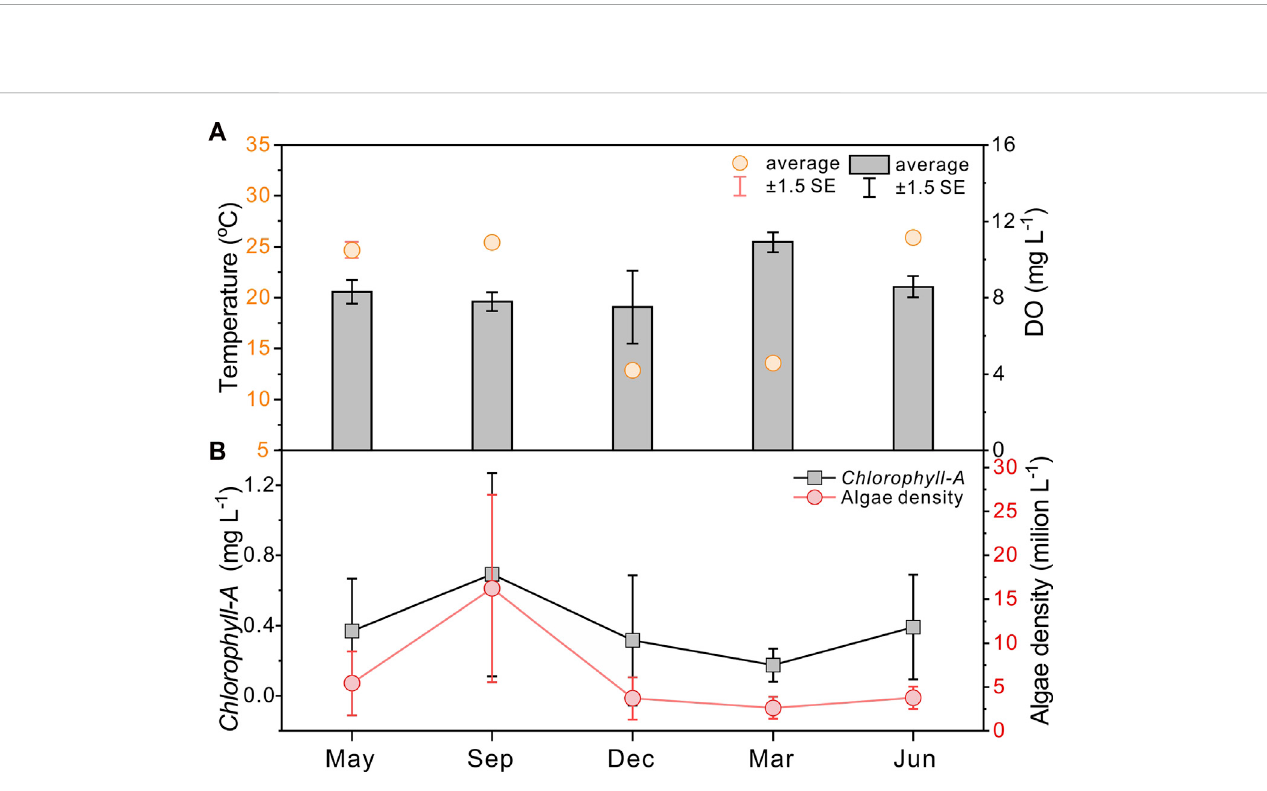
Frontiers in Earth